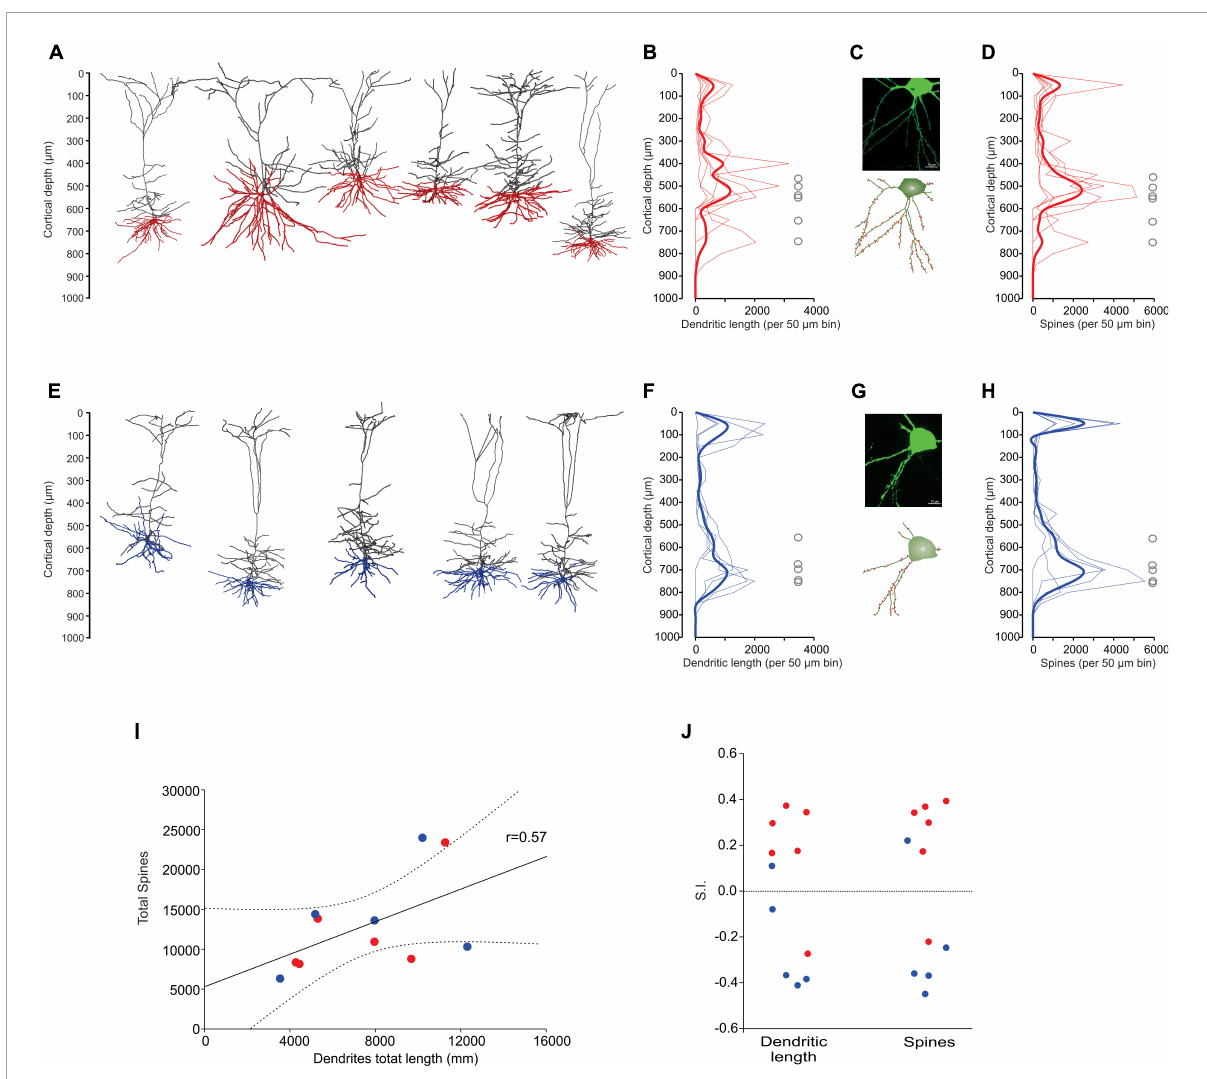
FIGURE4 Dendrite morphology of PTNs reflects subcortical targets. (A) Three-dimensional reconstructions of labeled CR neurons identified in vivo ( n = 6). Basal dendrites are indicated in red. (B) Distribution of dendrites along the vertical cortex axis. Each thin line corresponds to one neuron, and the average with the standard error is indicated by a thick line and shadow. The circles represent soma depth of each neuron. (C) Confocal microphotography of an exemplary CR neuron (upper) and its reconstruction (lower) showing the soma and some dendritic spines (red). (D) Distribution of dendritic spines along the vertical axis of the cortex. Each thin line corresponds to one neuron, and the average with the standard error is indicated by a thick line and shadow. (E–H) The same as (A–D) , but for CP neurons. (I) Dendritic path length per PTN is significantly correlated to the respective number of dendritic spines. (CR red circles, CP blue circles). Lines represent the linear regression and the upper and lower 99% confidence intervals. (J) Similarity indices (S.I.) between distributions along the cortex of dendrite density length and number of spines of each PTN. Notice that most of the similar neurons are of the same projection